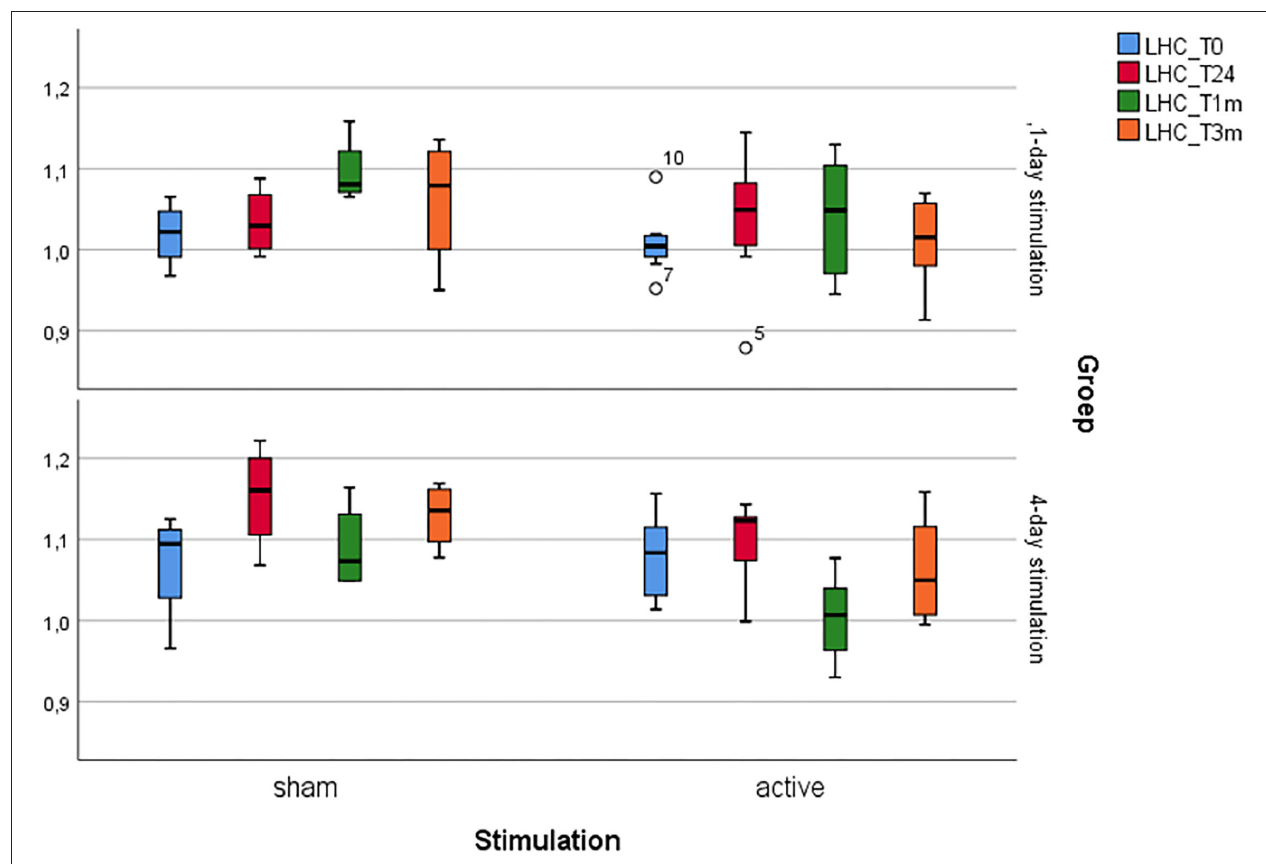
FIGURE 3 | Boxplot showing the glucose metabolism changes of the left